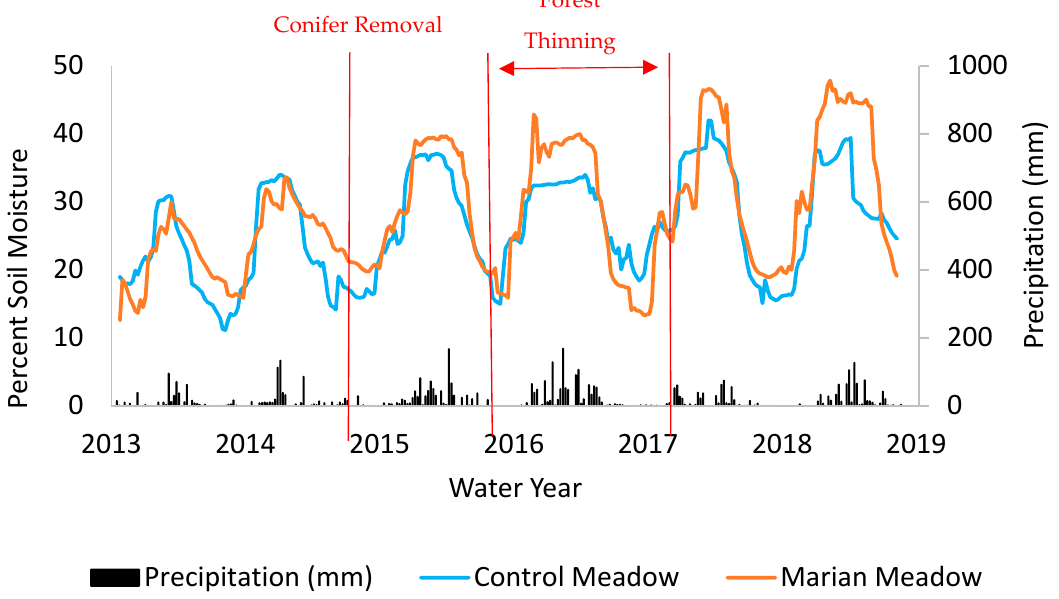
Figure 3. Week-averaged volumetric soil moisture (%) and precipitation (mm) for Control Meadow and Marian Meadow, 2013–2019. Table 2. Regression coefficients and statistics for soil moisture models.